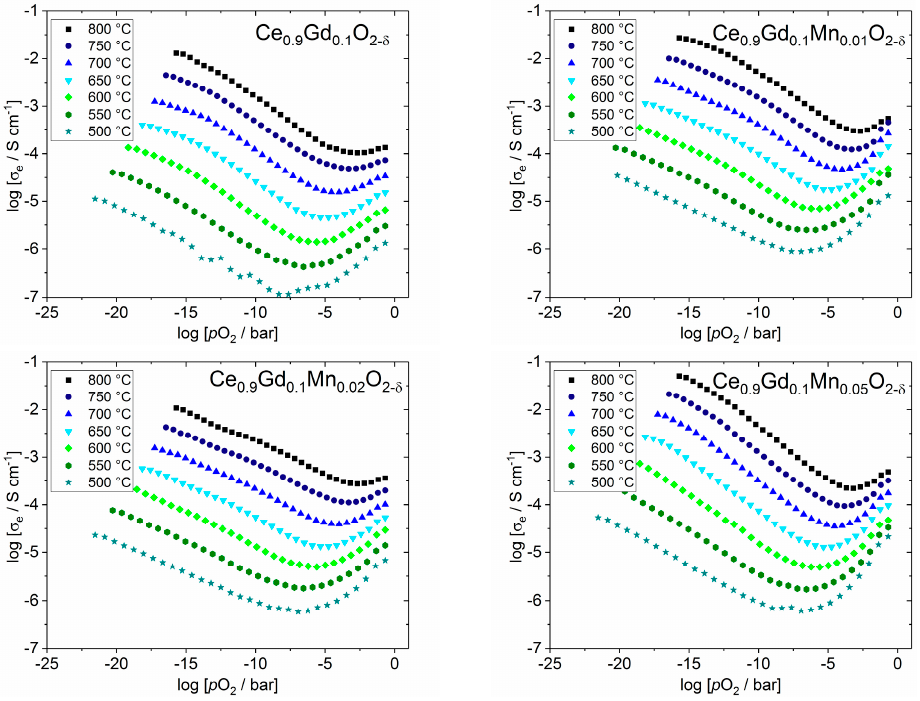
Figure 7. Oxygen partial pressure dependent conductivity for the four different samples. Average error